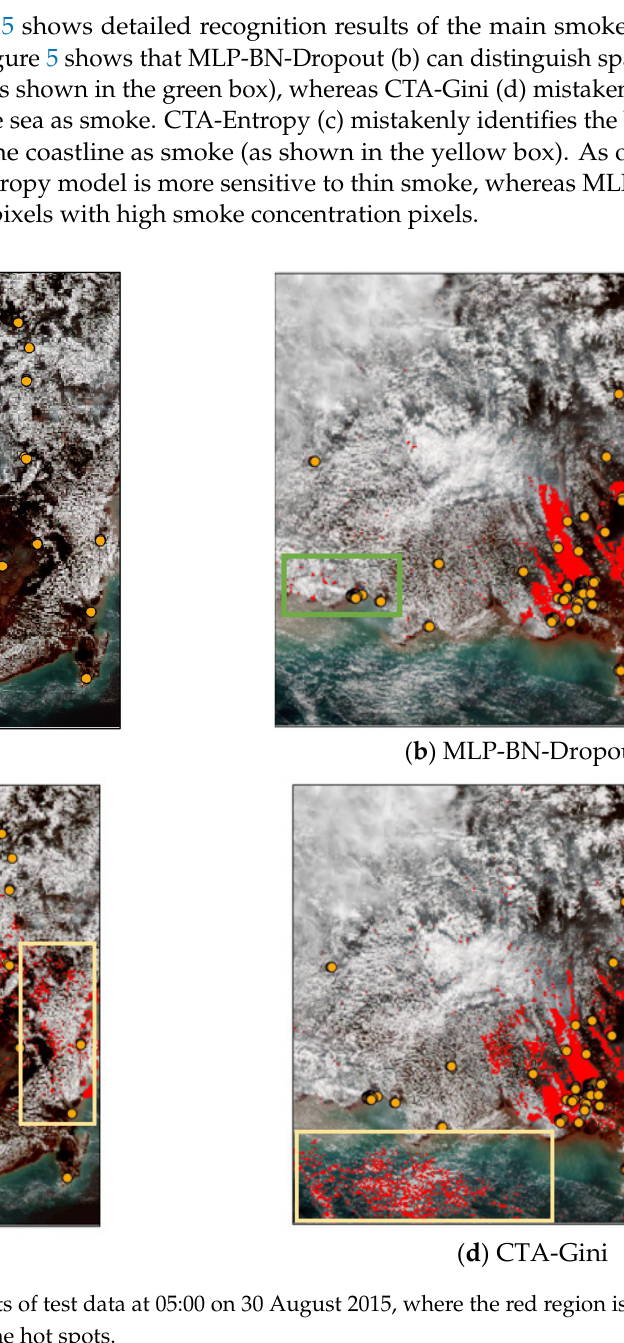
Figure 4. The visualization results are based on the histogram equalization images of test data from 30 August 2015. The first line represents the original data image of histogram equalization and the image superimposed with artificial labels (red region). The prediction results of each model are shown from the second line to the last line. The pixels marked in red in the lower six panels are the smoke pixels predicted by the model.